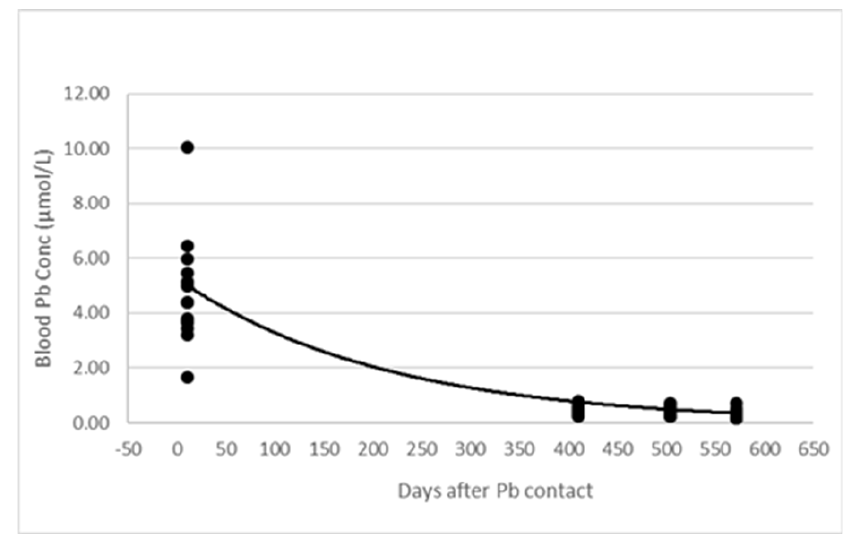
Figure 4. Depletion curve for blood lead concentration over 561 d for the 14